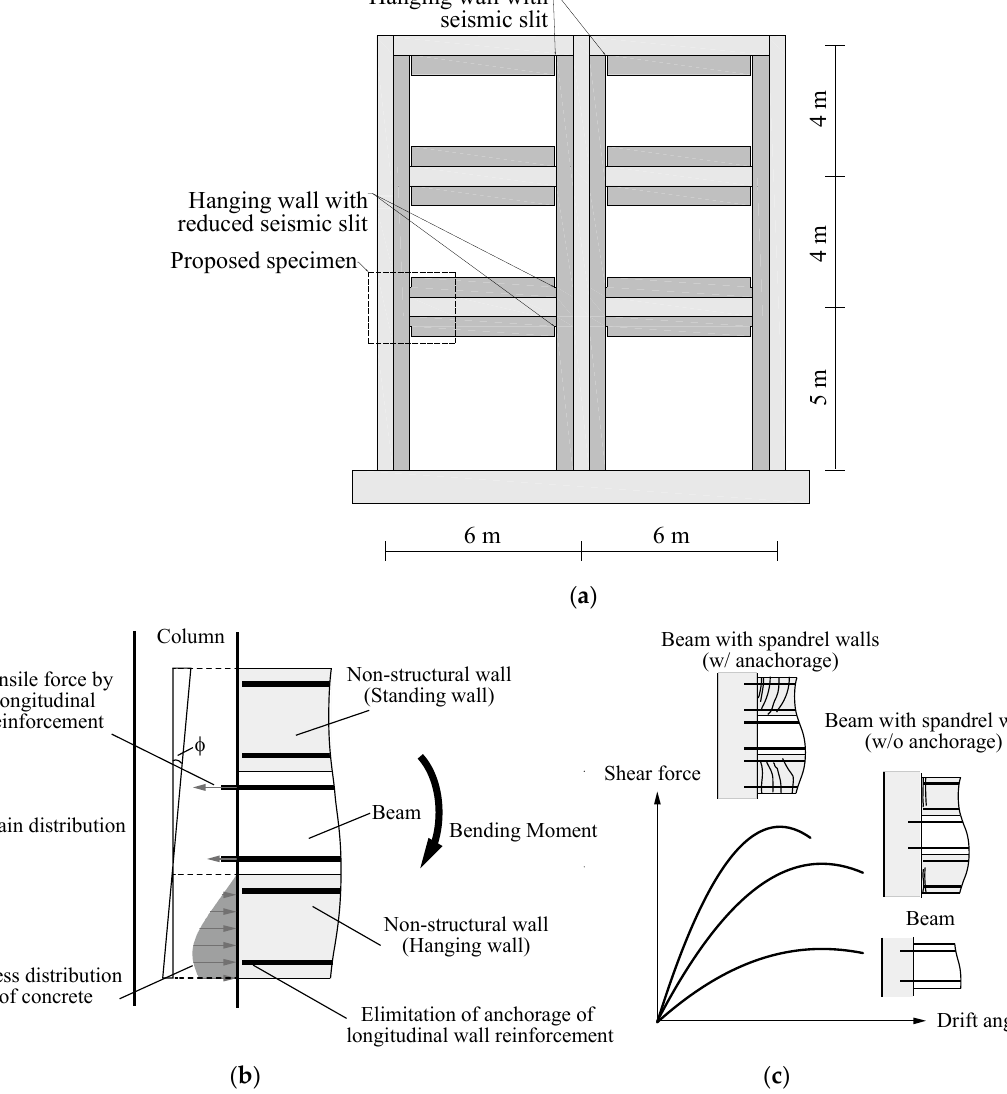
Figure 1. Proposed new detailing of reinforced concrete member with non-structural walls: ( a ) specimen position in the frame; ( b ) working mechanism; ( c ) expected performance.